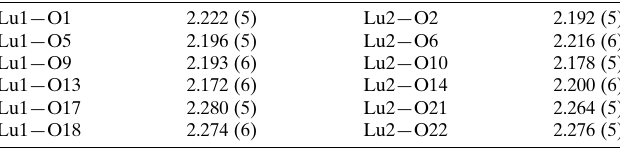
Table 1 Selected bond lengths (A˚ ).